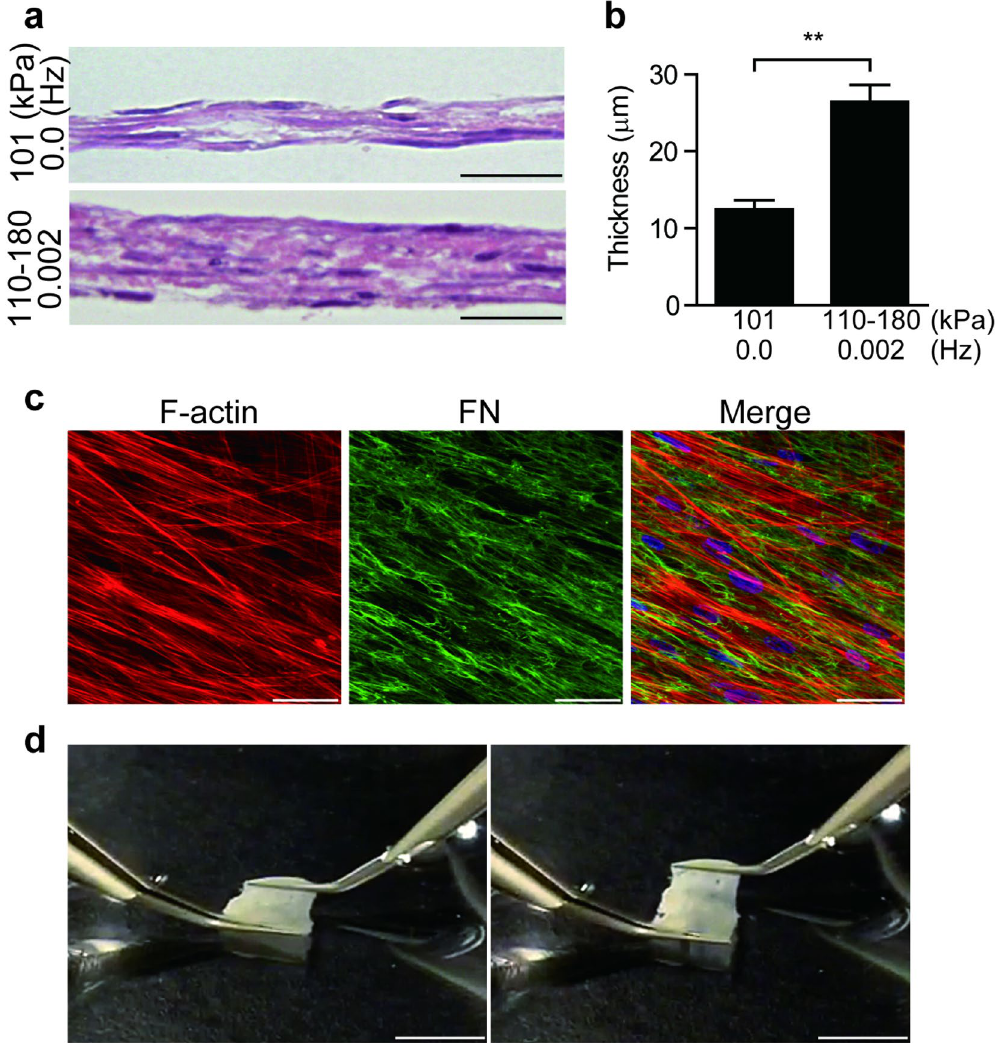
Figure 5. Layered structure of hUASMC constructs generated by repeated cell seeding and PHP. ( a ) Representative images of HE stain of hUASMC constructs. A lower panel shows a layered hUASMC construct generated by repeated cell seeding under PHP (110–180 kPa, 0.002 Hz) four times. The structure of hUASMCs made by the same time-course of repeated cell seeding, but without pressurization, is shown in an upper panel (101 kPa, 0.0 Hz). Scale bars: 20 μ m. ( b ) Quantification of thickness of hUASMC constructs generated under 101 kPa, 0.0 Hz (atmospheric pressure) and PHP, respectively. n = 4, ** p < 0.001. ( c ) Images of immunofluorescent stain for F-actin and FN in the layered structure of hUASMCs generated by PHP are shown. Scale bars: 50 μ m. ( d ) Images of the layered structure of hUASMCs generated by PHP. Stretched and unstretched hUASMC constructs are shown in the right and left panels, respectively. Scale bars: 5 mm. Values are shown as the mean ± standard error of the mean (SEM) of independent experiments. Data were analyzed using two-tailed unpaired Student’s t